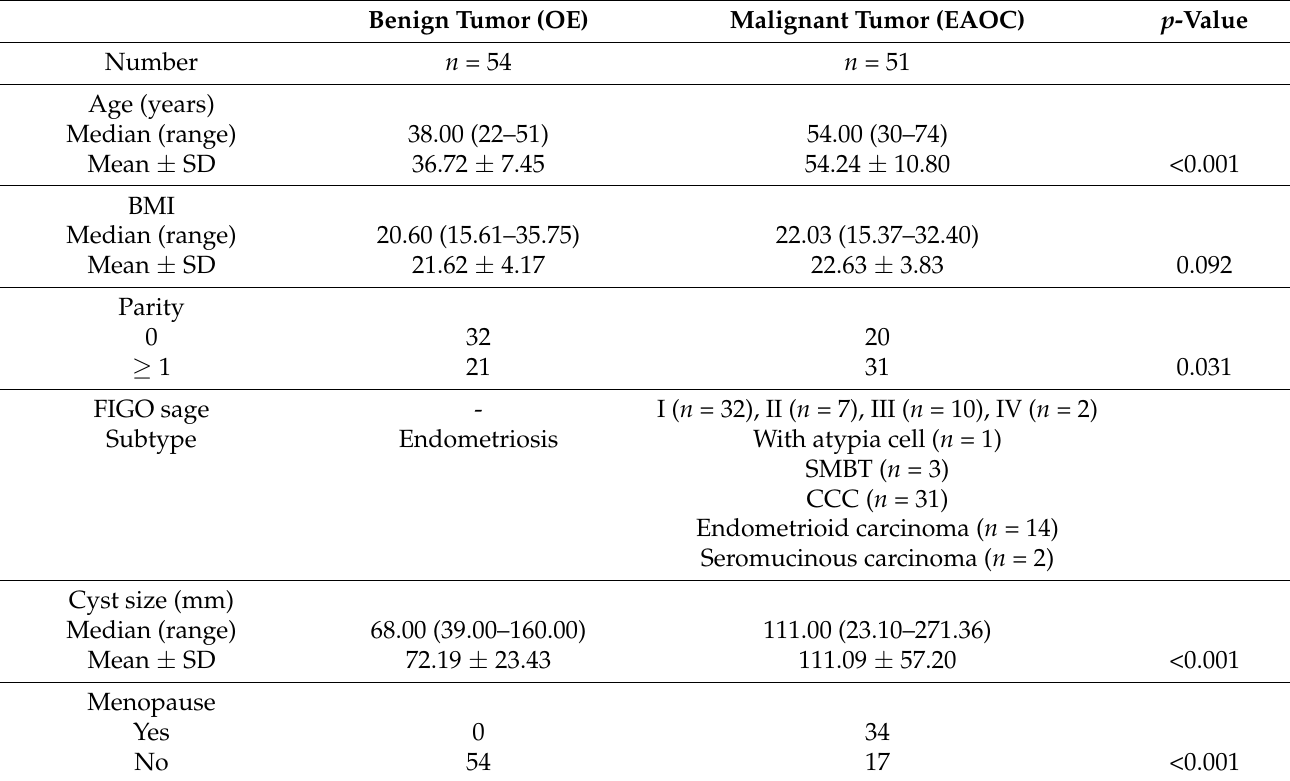
Table 2. Demographic and clinical characteristics of the validation